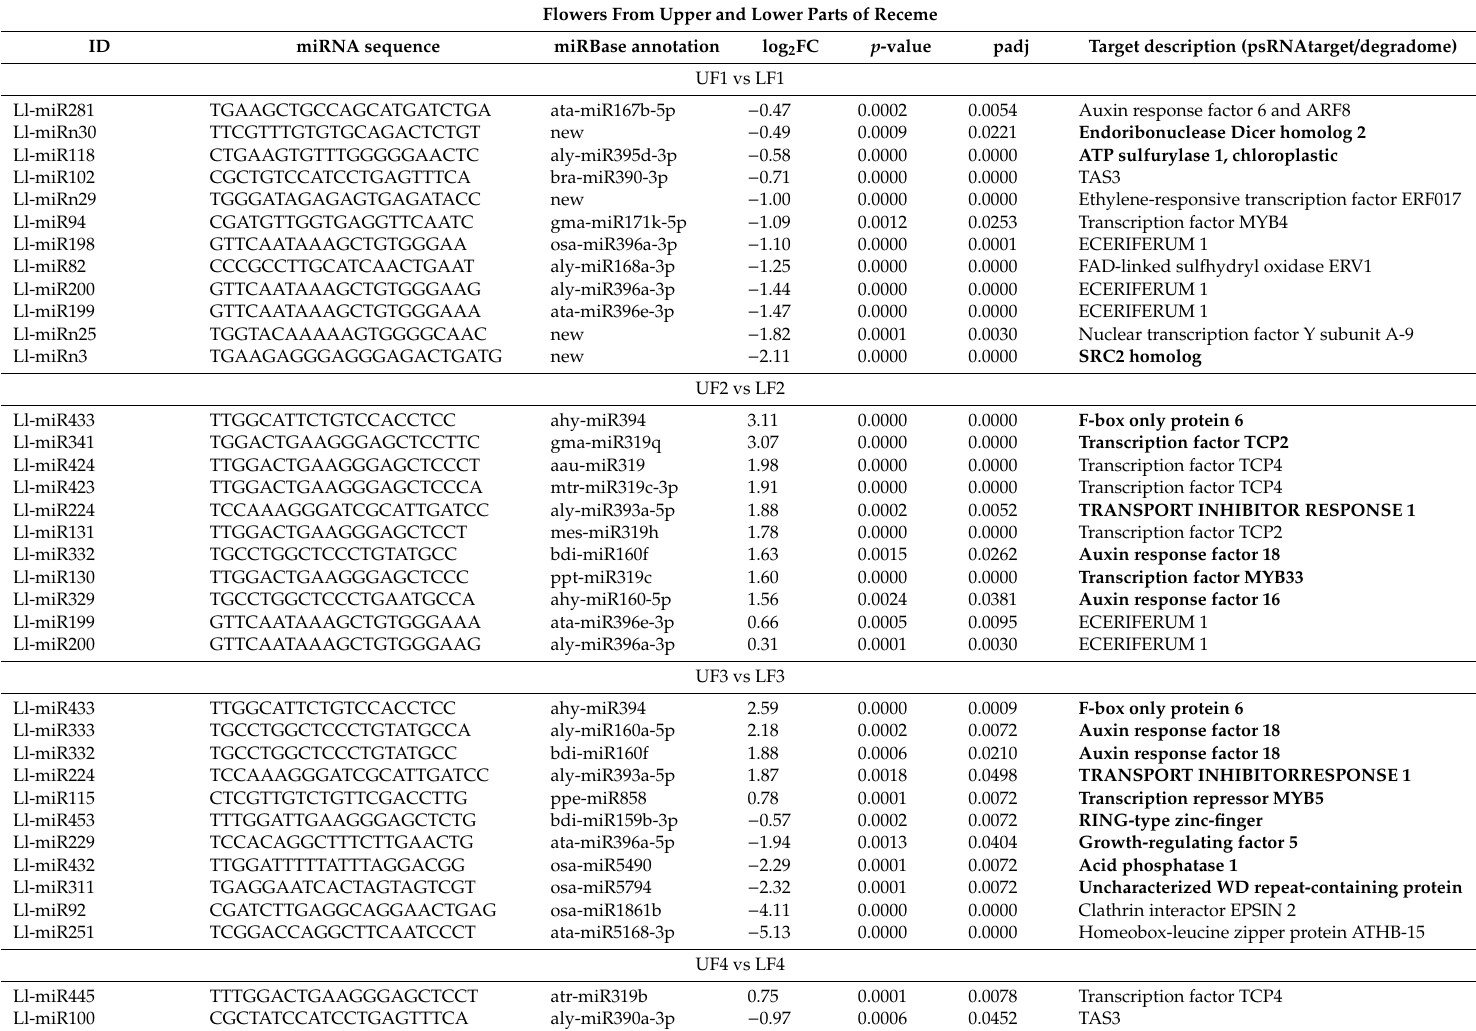
Table 5. Di ff erentially expressed miRNAs identified in comparisons between flowers from lower and upper parts of the raceme with padj < 0.05. Flowers From Upper and Lower Parts of